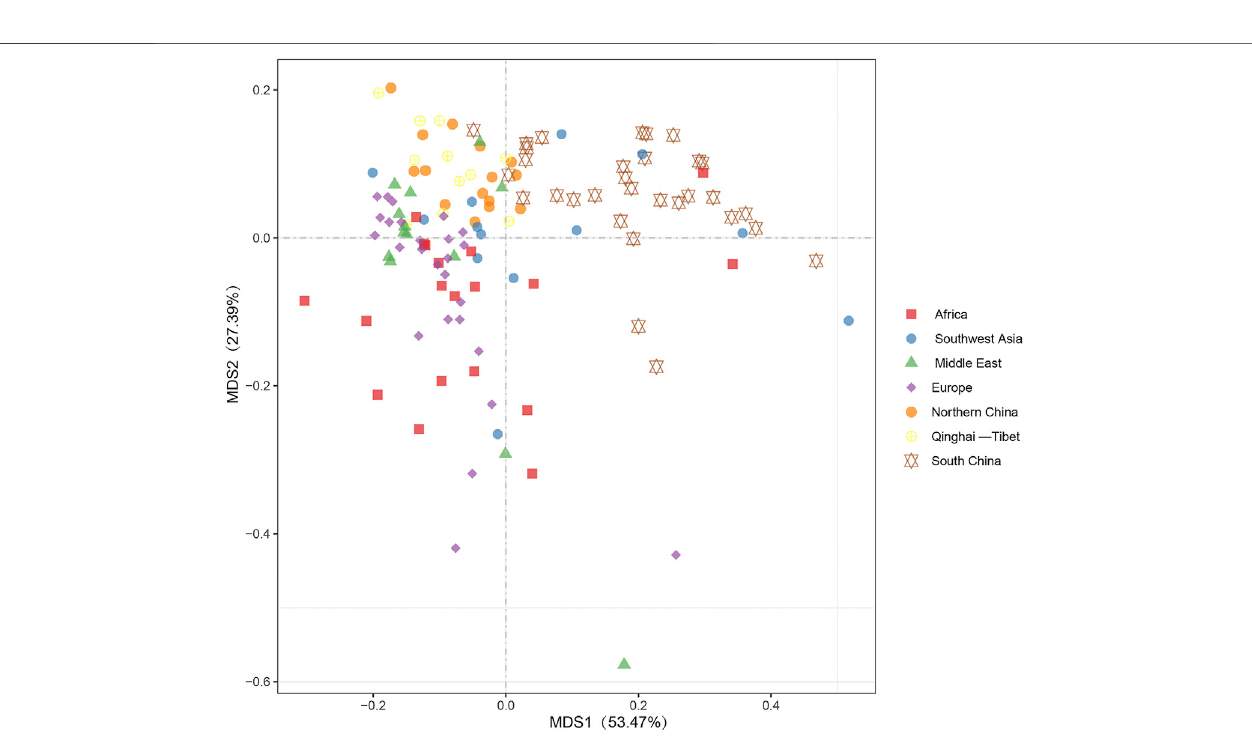
Frontiers in Genetics |